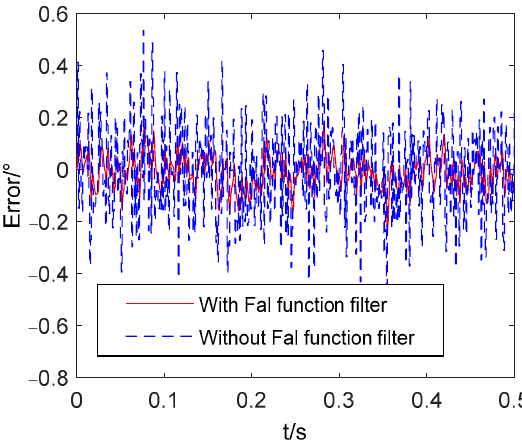
Figure 10. Error comparison for filter performance.